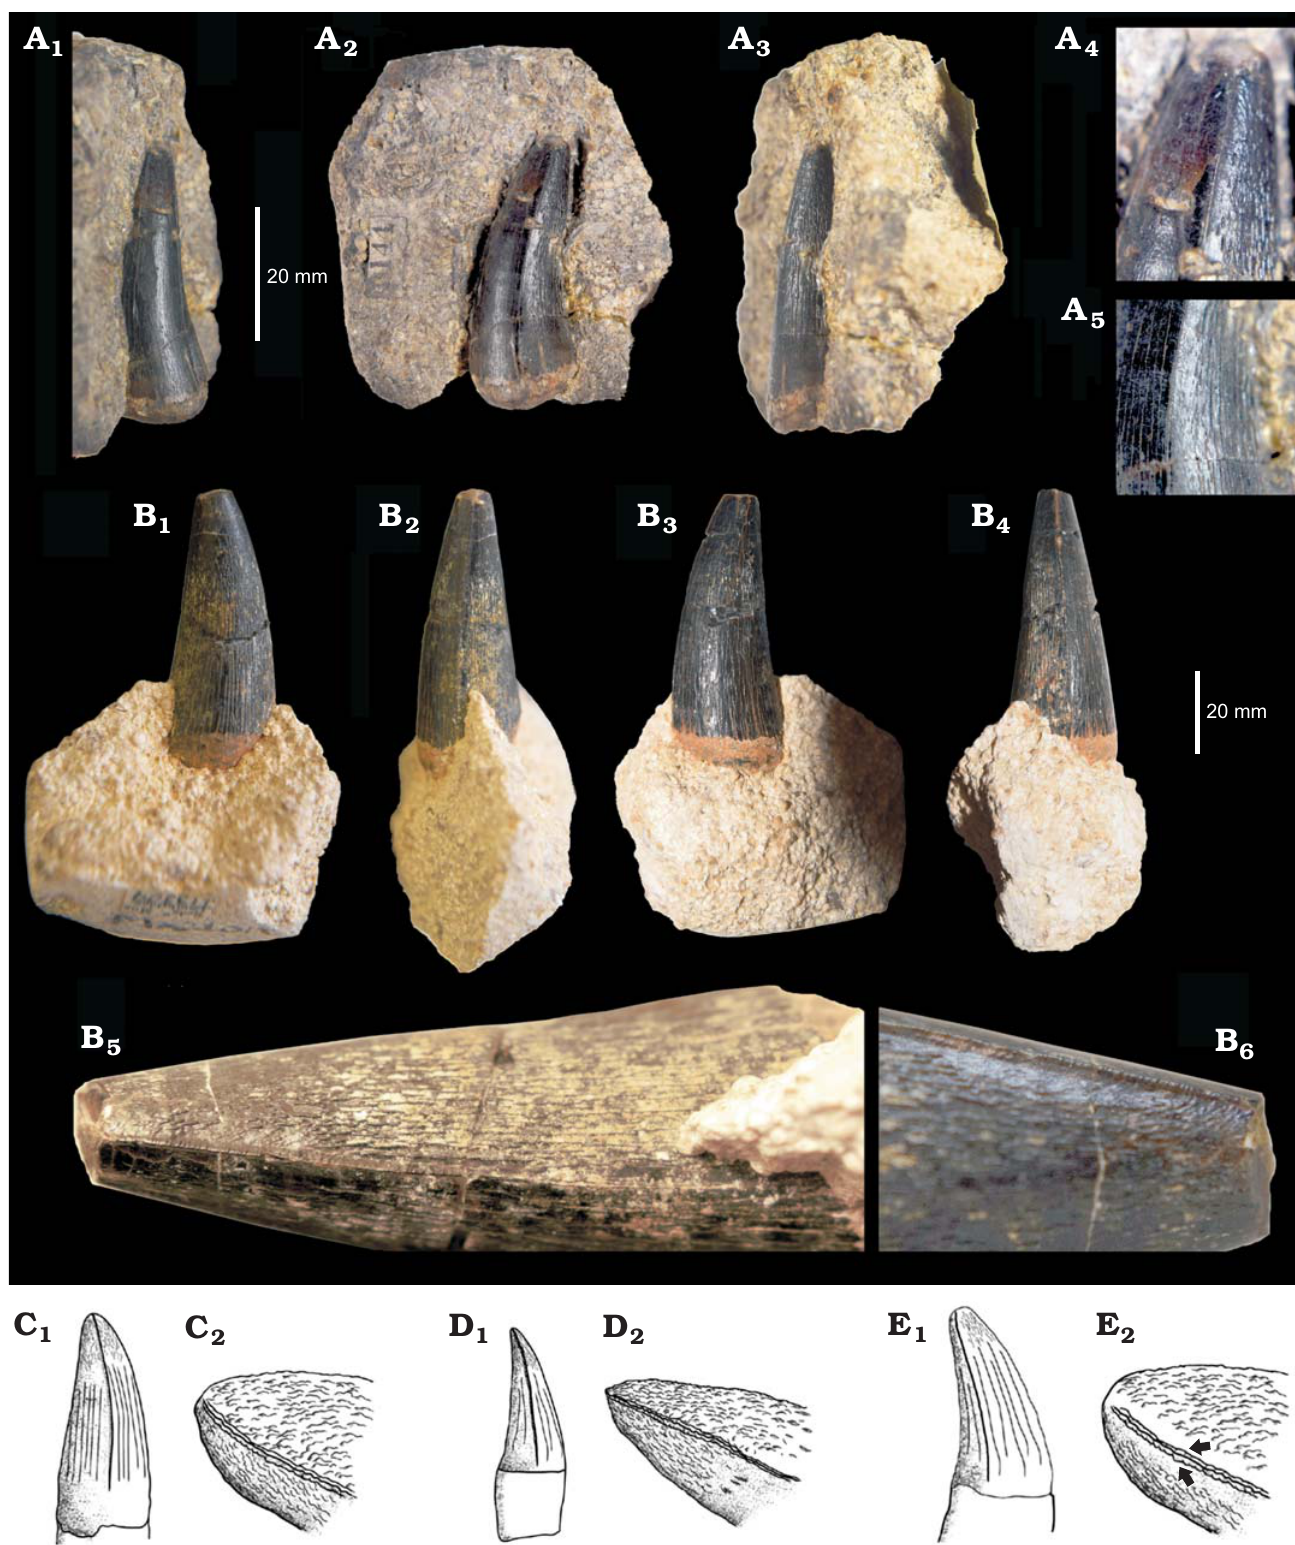
Fig. 10. Teeth of the metriorhynchid reptile Torvoneustes sp. A . YORYM:2016.309, from Malton (Yorkshire), middle Oxfordian, in labial (A 1 ), axial (A 2 ), and lingual (A 3 ) views, and close ups of the carina and ornamentation (A 4 , A 5 , not to scale). B . CAMSM J.13309, from Malton (Yorkshire), mid- dle Oxfordian, in labial (B 1 ), axial (B 2 , B 4 ), lingual (B 3 ) views, and close ups of the carinae (B 5 , B 6 , not to scale). C – E . Comparative line drawings ( C , Torvoneustes carpenteri ; D , T. mexicanus ; E , T. coryphaeus ) teeth (C 1 –E 1 , not to scale) and details of ornamentation (C 2 –E 2 , not to scale), the arrows